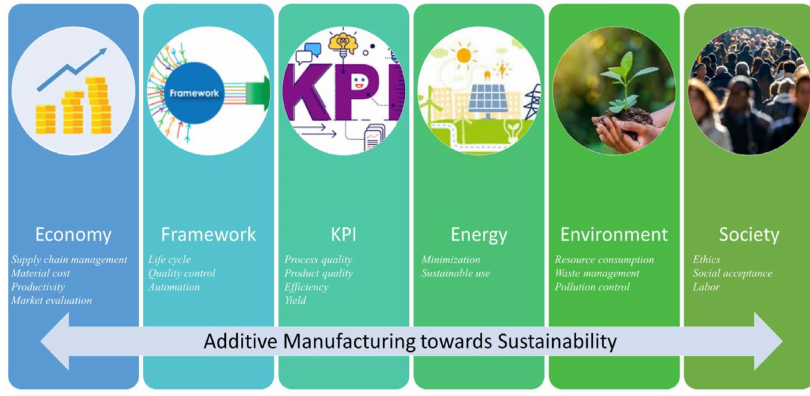
Figure 16. Additive manufacturing toward sustainability.